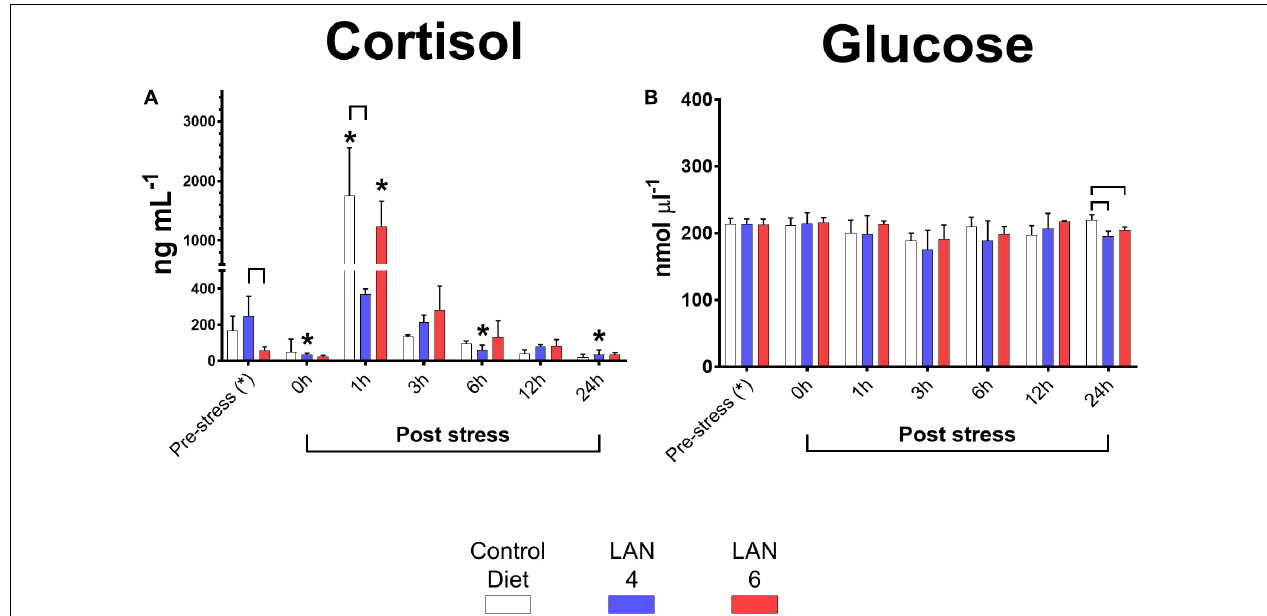
FIGURE 1 | Circulating cortisol and glucose in the plasma of Atlantic salmon exposed to acute hypoxia stress. (A) Cortisol (ng ml − 1 ). (B) Glucose level (nmol µ l − 1 ). Sampling times: pre-stress, 0 h (immediately after stress), 1, 3, 6, 12, and 24 h post-stress. In white, CD. In blue, LAN4. In red, LAN6. Each bar: n = 4. *: Significant differences ( p < 0.05) compared with pre-stress group (from each diet). Bracket: significant differences ( p < 0.05) among dietary groups within sampling time (CD, LAN4, and LAN6, respectively).